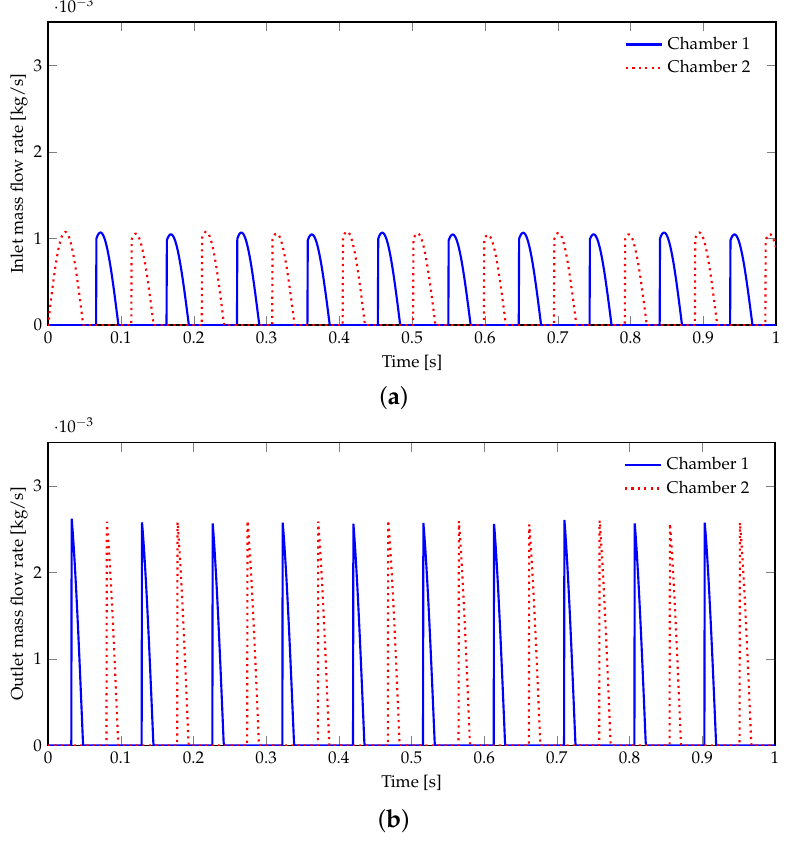
Figure 10. The mass flow rate of the compressor for ( a ) inlet gas, and ( b ) outlet gas, for both chambers (the chambers work in 90 ◦ phase difference).